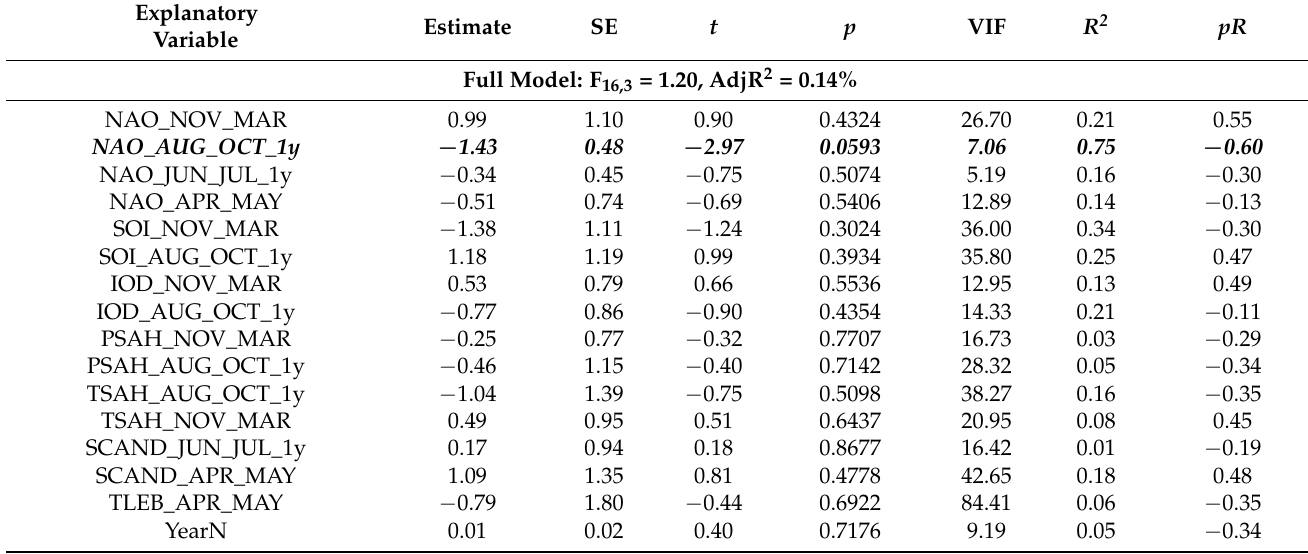
Table A6. Relationships between 15 climate variables and year in full models and Annual Anomaly of the timing of spring migration for the Common Whitethroat Curruca communis caught at Bukowo, Poland, in 1982–2021. Symbols as in Tables 1 and A5. 0.05 < p < 0.1 marked in bold italics